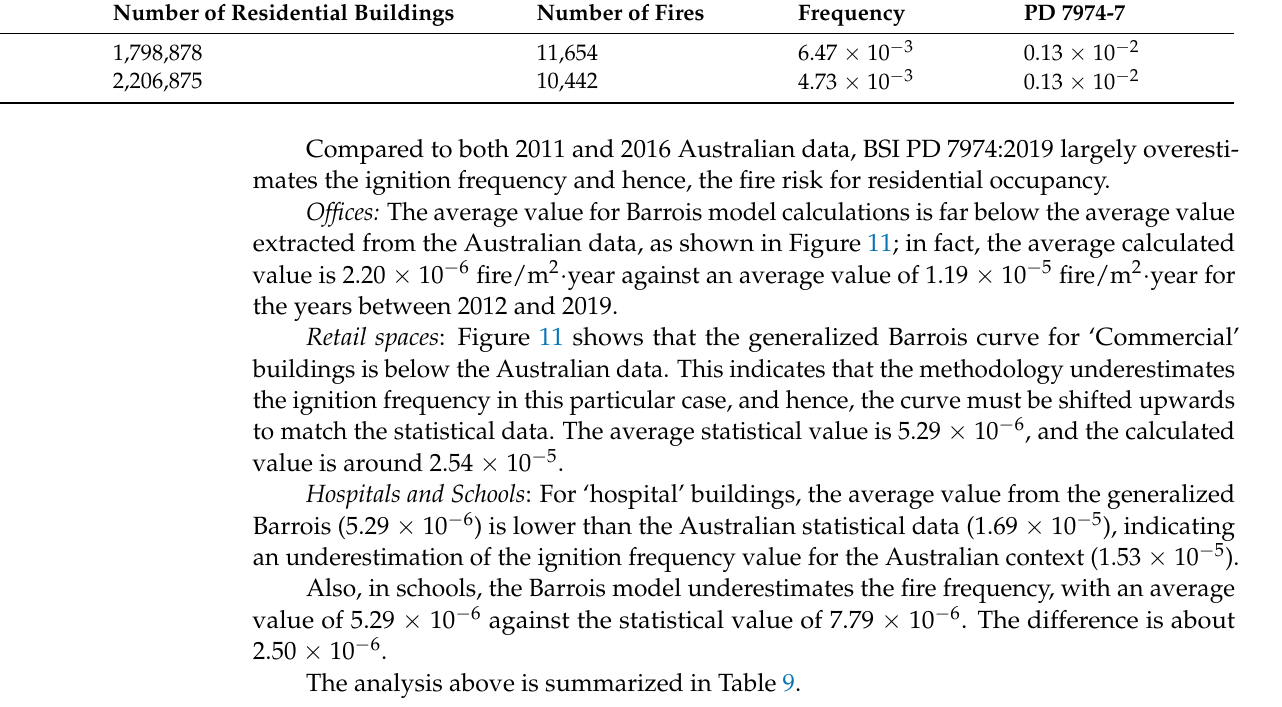
Table 9. Summary of the ignition frequency comparison for different building